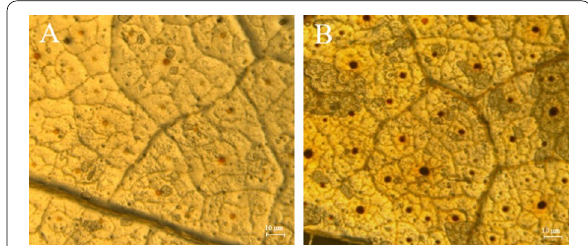
Fig. 6 EBS03 triggered the outbreak of reactive oxygen species in cotton leaf. A control; B treated with EBS03